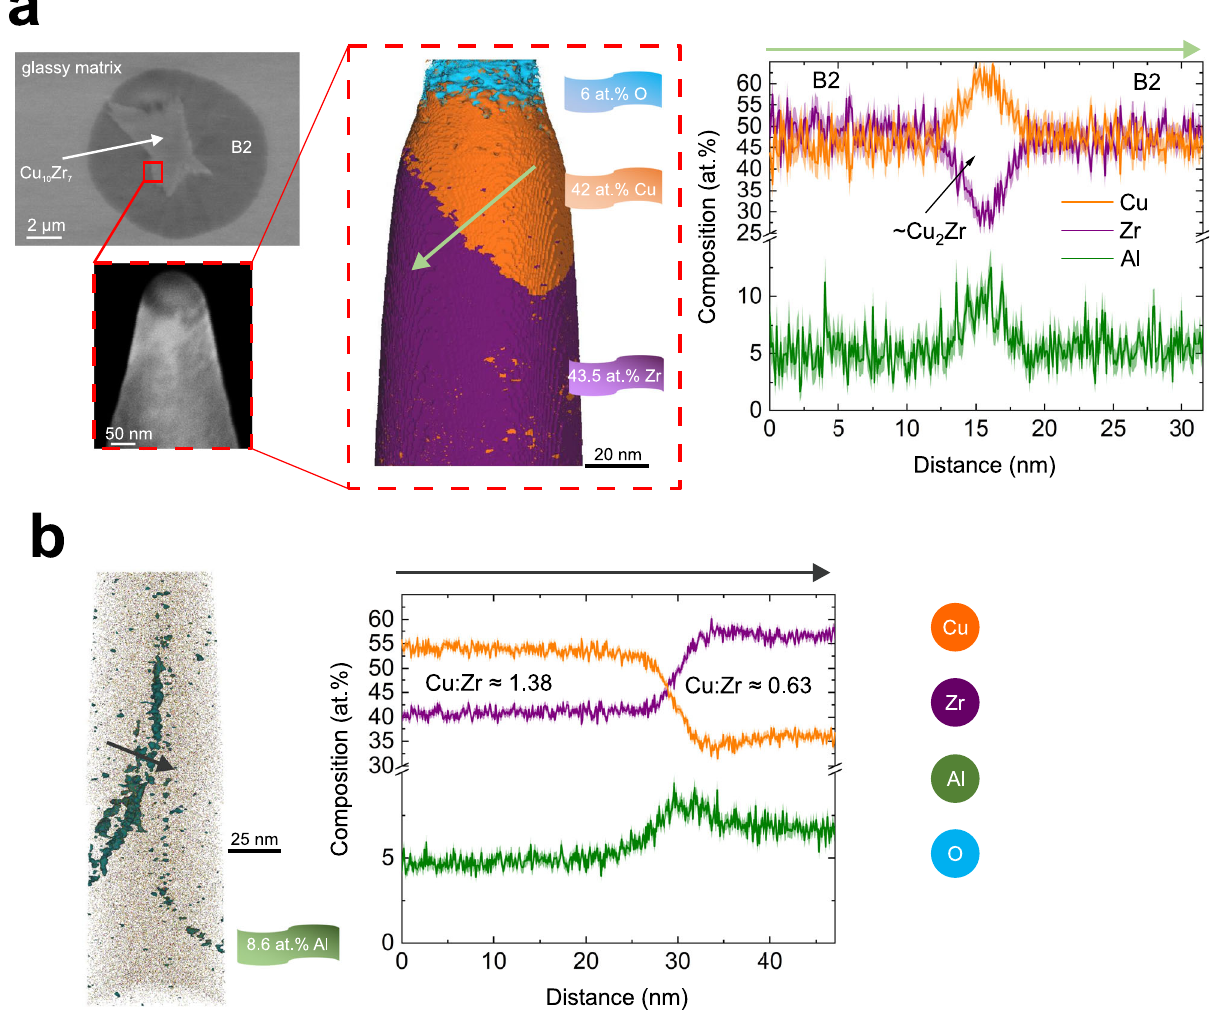
Fig. 8 Atom probe tomography reconstructions of the local microstructure of a metallic-glass-crystal composite formed in a chamber fl uxed with He. a Left: SEM micrographs showing the B2 (spheroid)/Cu 10 Zr 7 (dendrite) interface from which an APT sample was prepared. Middle: APT volume rendering of the interface. Right: The corresponding 1-D concentration pro fi le. b APT volume rendering of Al from a different region and showing the